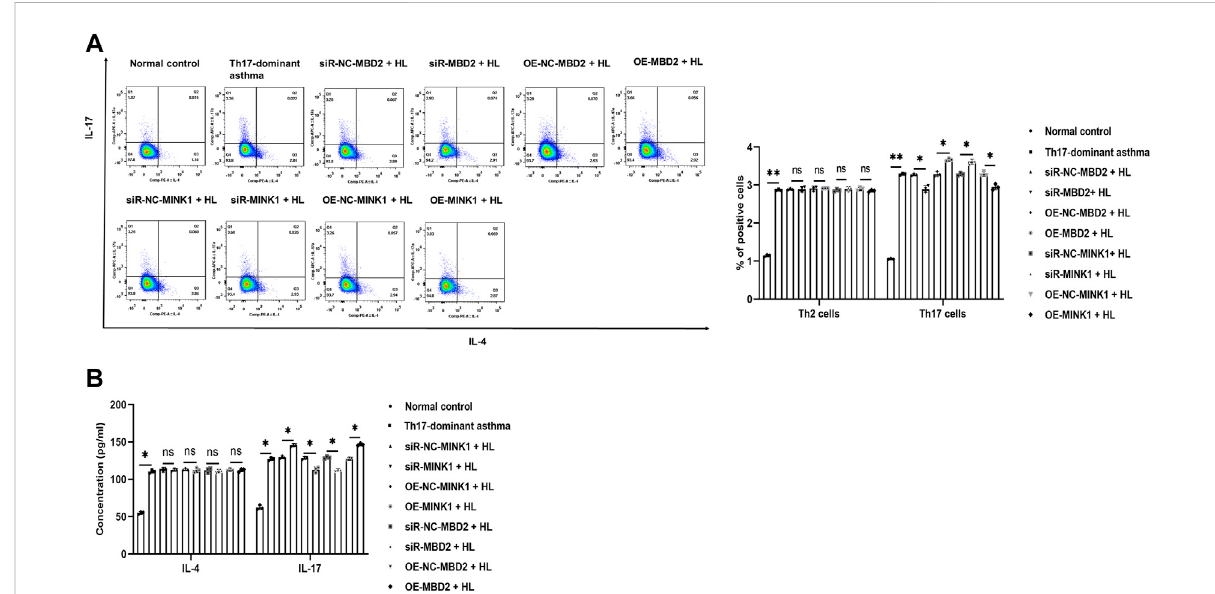
FIGURE 5 Th17 cell differentiation under MBD2 and MINK1 gene silencing or overexpression (A and B) After the MBD2 or MINK1 gene was transfected in BECswithHDM+LPSexposureandcoculturedwithCD4 + Tcellsfor24 h,theexpressionofTh2andTh17cellswasdetectedby fl owcytometry,and the levels of IL-17 and IL-4 in the cell supernatant were detected by ELISA. (C and D) After the transfection of the MBD2 or MINK1 gene in BECs without HDM + LPS exposure and cocultured with CD4 + T cells for 24 h, the expression of Th2 and Th17 cells was detected by fl ow cytometry, and the levels of IL-17 and IL-4 in the cell supernatant were detected by ELISA. * p < 0.05. ** p < 0.01. HL, HDM +